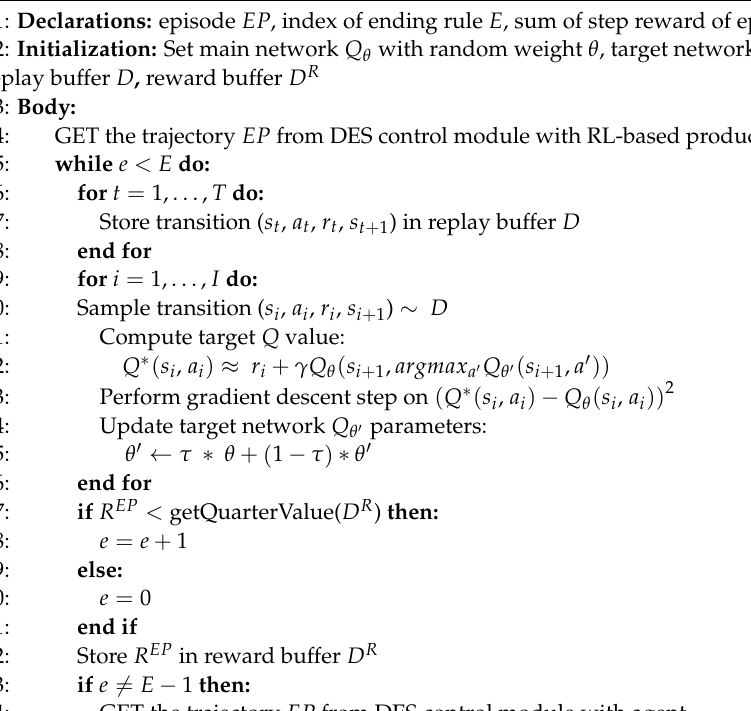
Algorithm 1 DDQN-based scheduling algorithm